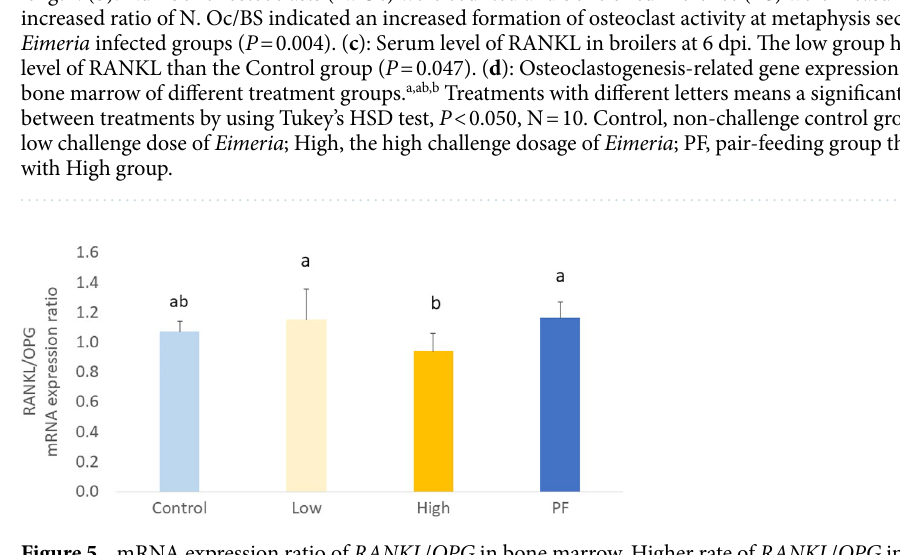
Pearson correlation analyses revealed a negative correlation of the liver TBAR level with femur growth rate (R 2 = 0.249, P = 0.005) and between the liver TBAR level and tibia growth rate (R 2 = 0.330, P = 0.001). There was a positive correlation between serum total antioxidant capacity and metaphysis bone mineral density (R 2 = 0.219, P = 0.0182); and a negative correlation between the liver TBAR level and metaphysis bone mineral density (R 2 = 0.391, P < 0.001). Meanwhile, bone marrow BGLAP mRNA level was negatively correlated with the liver TBAR level (R 2 = 0.130, P = 0.031) and positively correlated with serum total antioxidant capacity (R 2 = 0.227, P = 0.004).